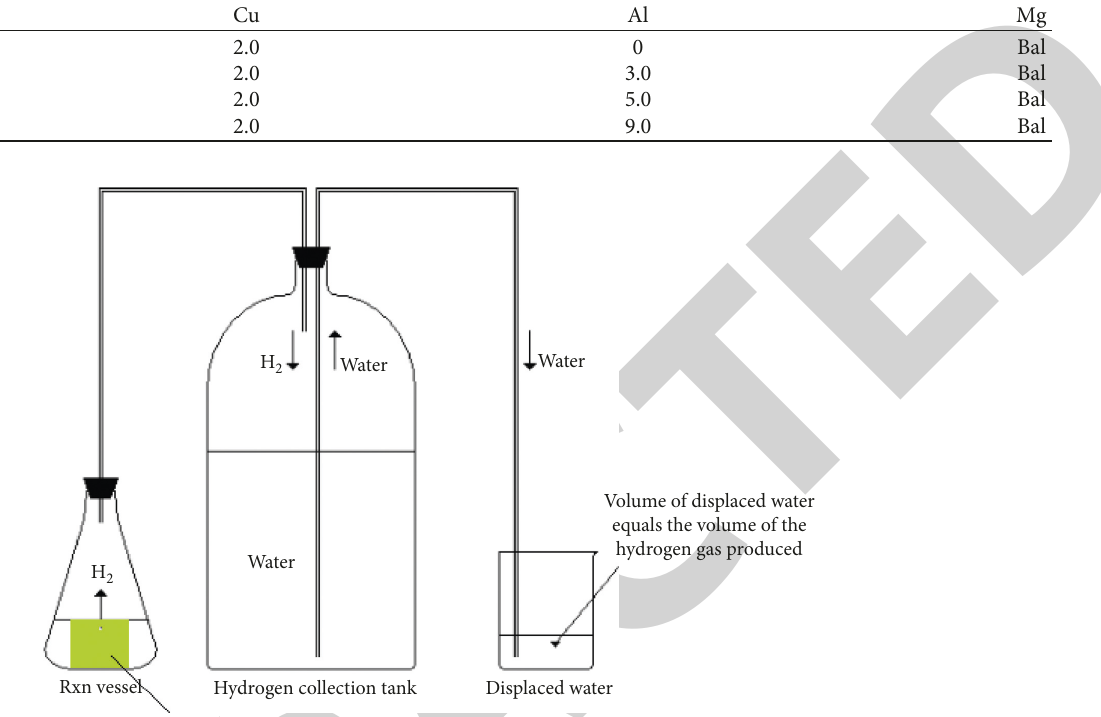
Figure 1: Schematic illustration of degradation rate measurement by collecting the volume of hydrogen.